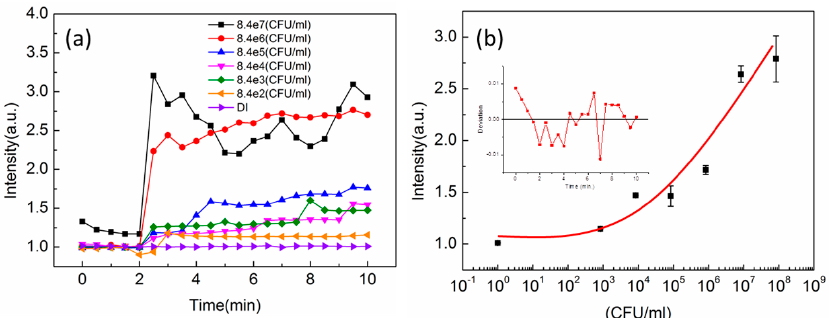
Figure 6. ( a ) The measured intensity as a function of time for different concentration of E. coli . Different concentration of E. coli bacteria can be clearly discriminated less than 10 min; ( b ) The measured intensity vs. the E. coli concentration at the saturation condition. The inset shows the measured noise level for low concentration of E. coli